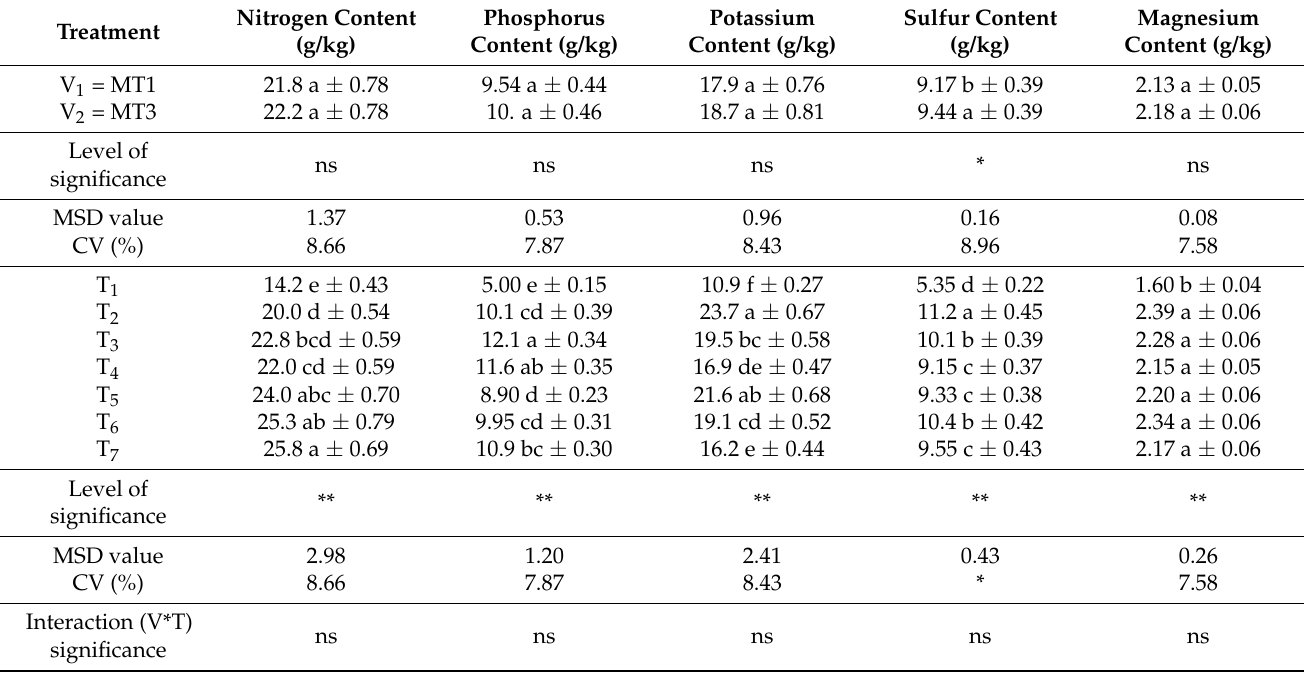
Table 9. Effect of zinc fertilizer and zinc oxide nanoparticles on nitrogen, phosphorus, potassium, sulfur, and magnesium content in fruits of two selected tomatoes varieties.